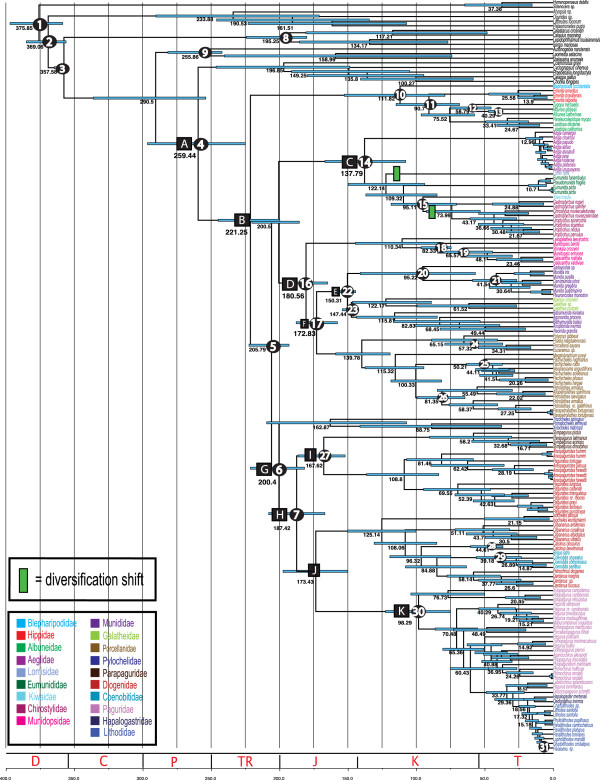
Divergence time chronogram using Bayesian evolutionary analysis by sampling trees using BEAST. Fossil calibration points are indicated by numbers 1–31 embedded in black circles (refer to Table 2). Divergence time estimates (MY) are noted adjacent to their respective nodes and blue nodal bars correspond to the 95% highest posterior density regions. Geological periods are superimposed onto the phylogeny and listed as follows: D, Devonian; C, Carboniferous; P, Permian; TR, Triassic; J, Jurassic; K, Cretaceous; T, Tertiary. Colored taxa correspond to anomuran families as noted in the legend. Green boxes indicate a diversification shift.